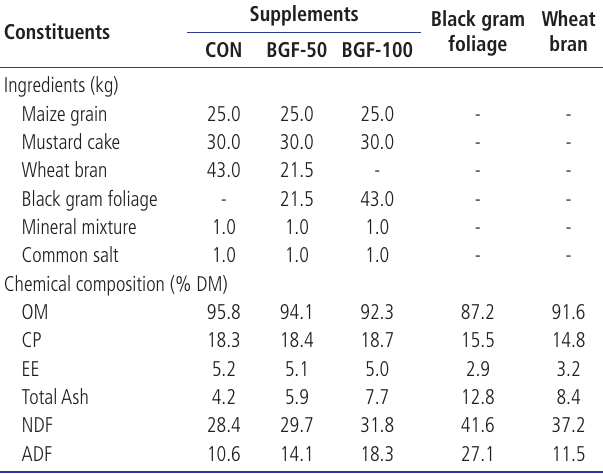
Table 1. Ingredients and chemical composition of supplements, black gram